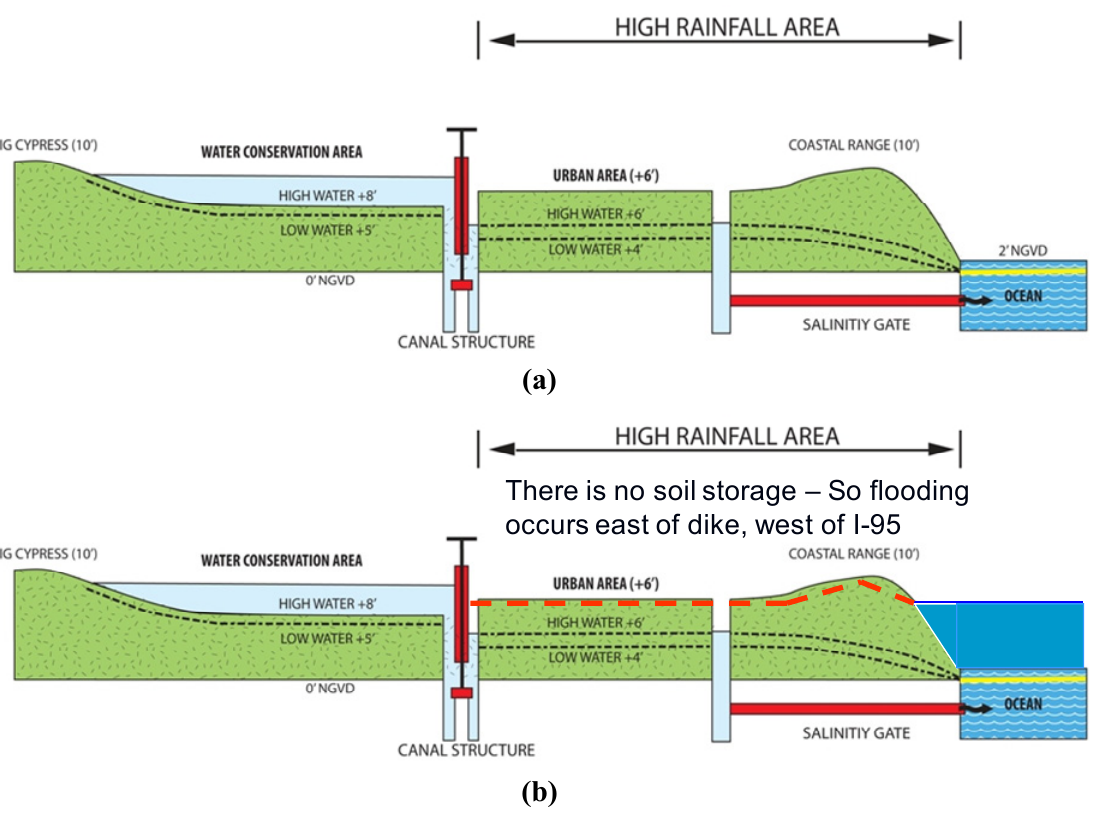
Figure 2. ( a ) Cross-section of SE Florida prior to the canal systems and ( b ) post canal construction showing the impact of sea level rise on aquifer levels (thick, dashed